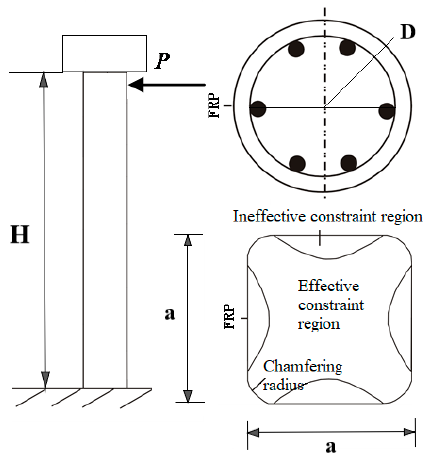
Figure 5. Section shape and loading form of FRP-C RC columns.